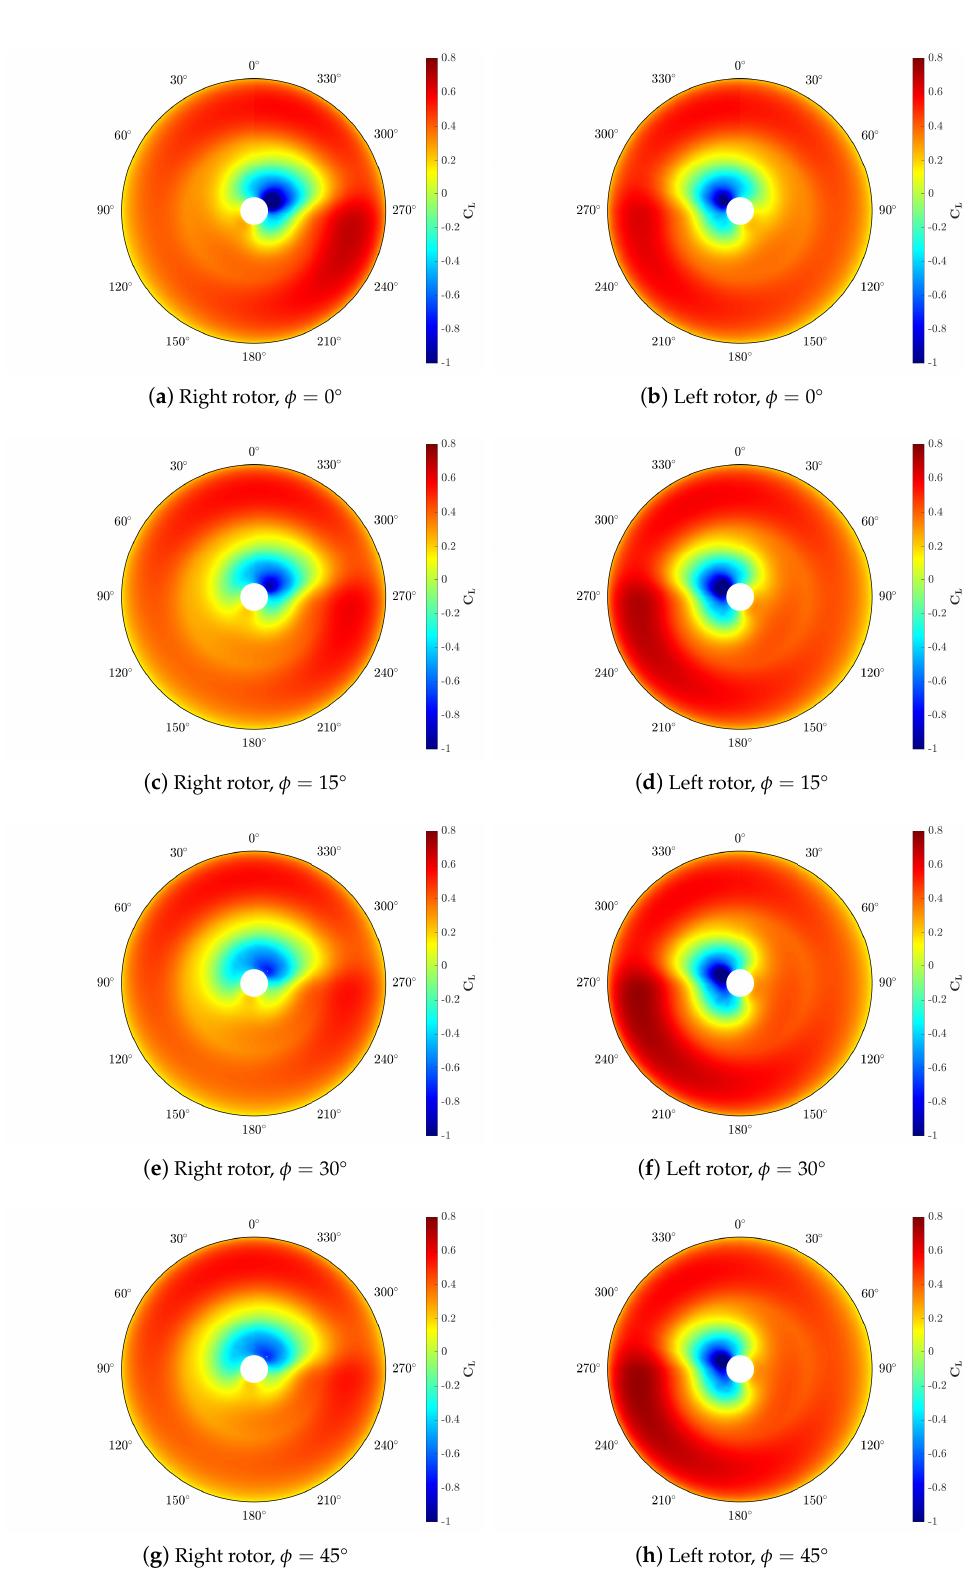
Figure 23. Lift coefficient disks at various bank angles φ , front view as shown in Figure